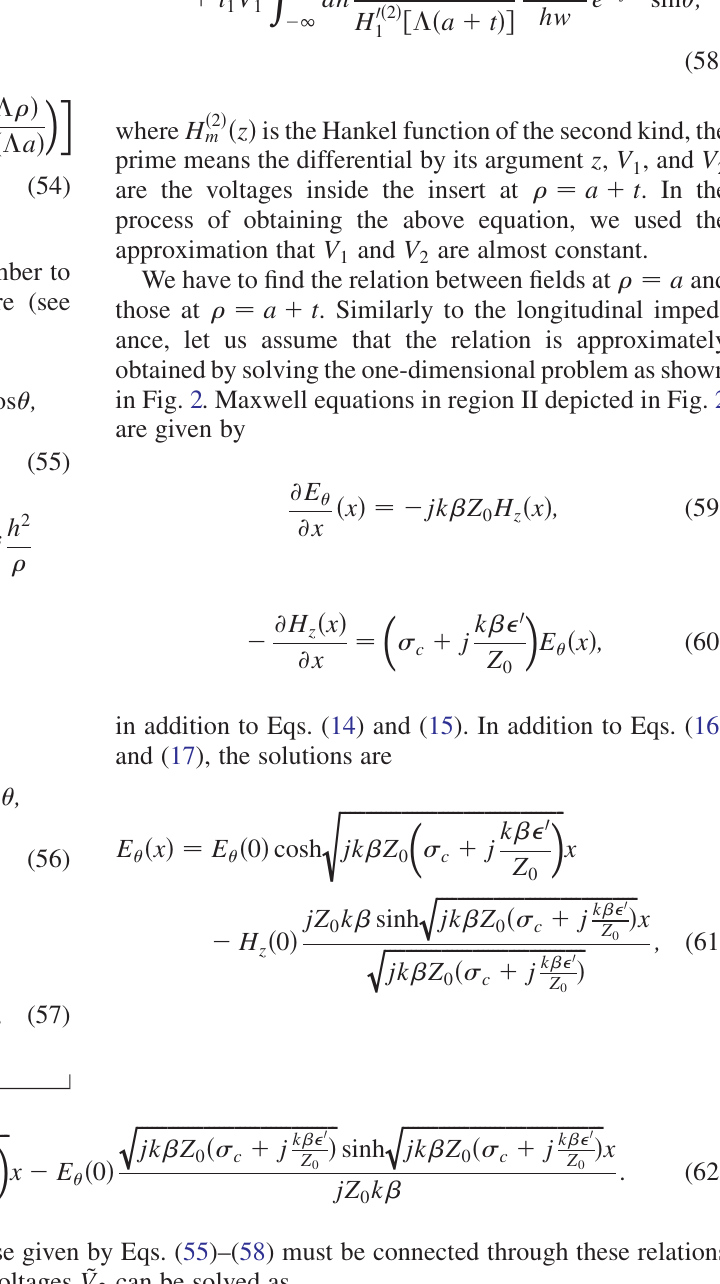
ffiffiffiffiffiffiffiffiffiffiffiffiffiffiffiffiffiffiffi jk(cid:4)Z